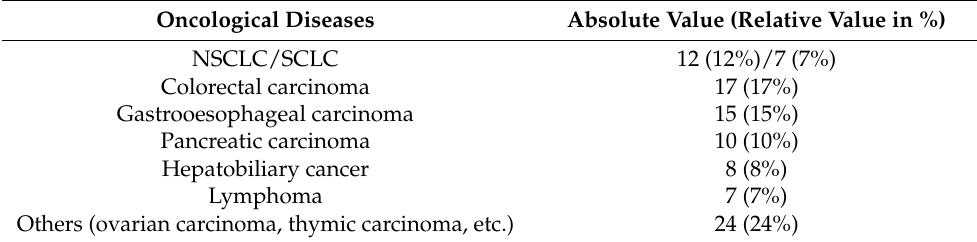
Table 1. Distribution of oncological disease among the